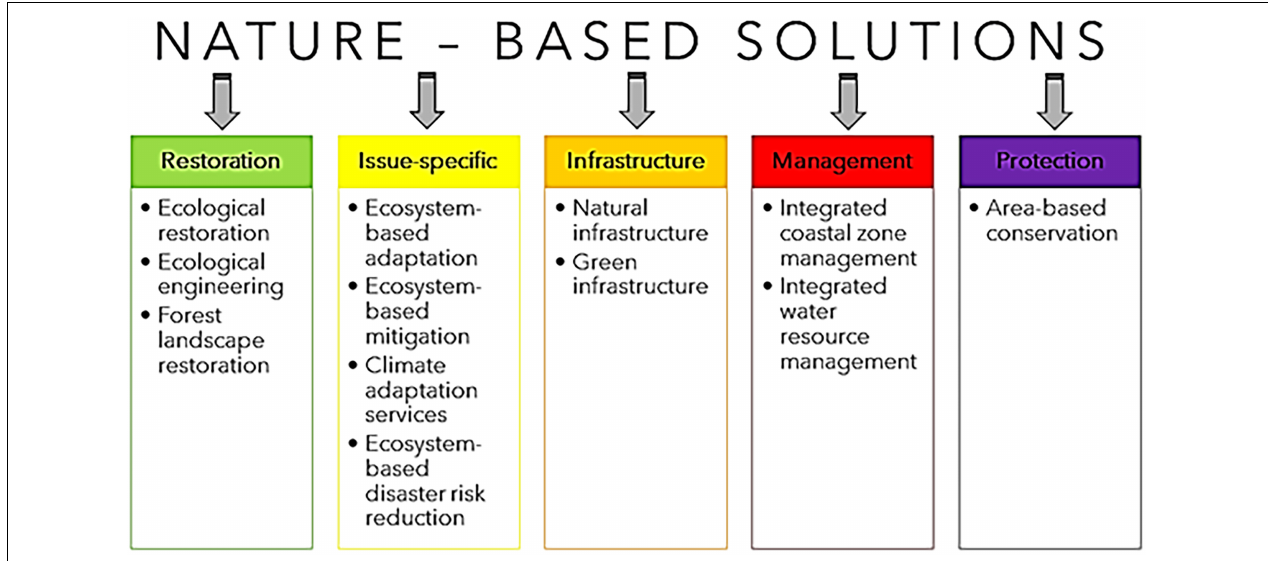
FIGURE 2 | Conceptual representation of the NbS umbrella for five categories of Nature-based Solution approaches (adapted from Figure 6 in Cohen-Shacham et al., 2016).